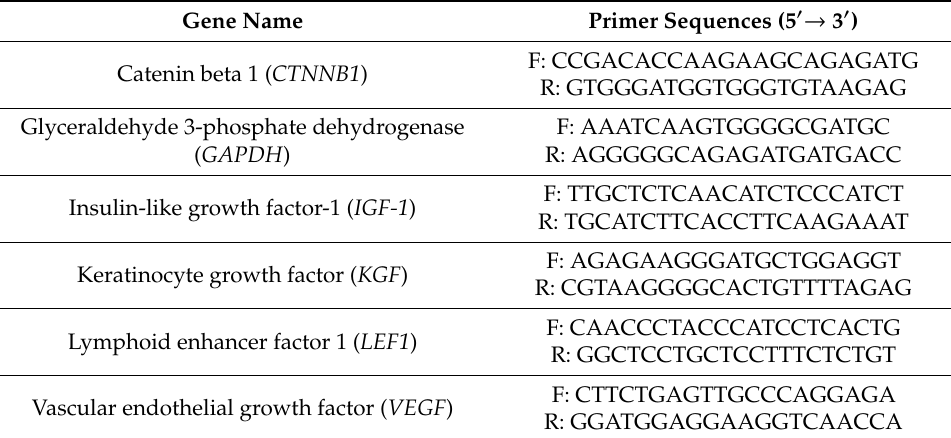
Table 1. Primer sequences used for real-time